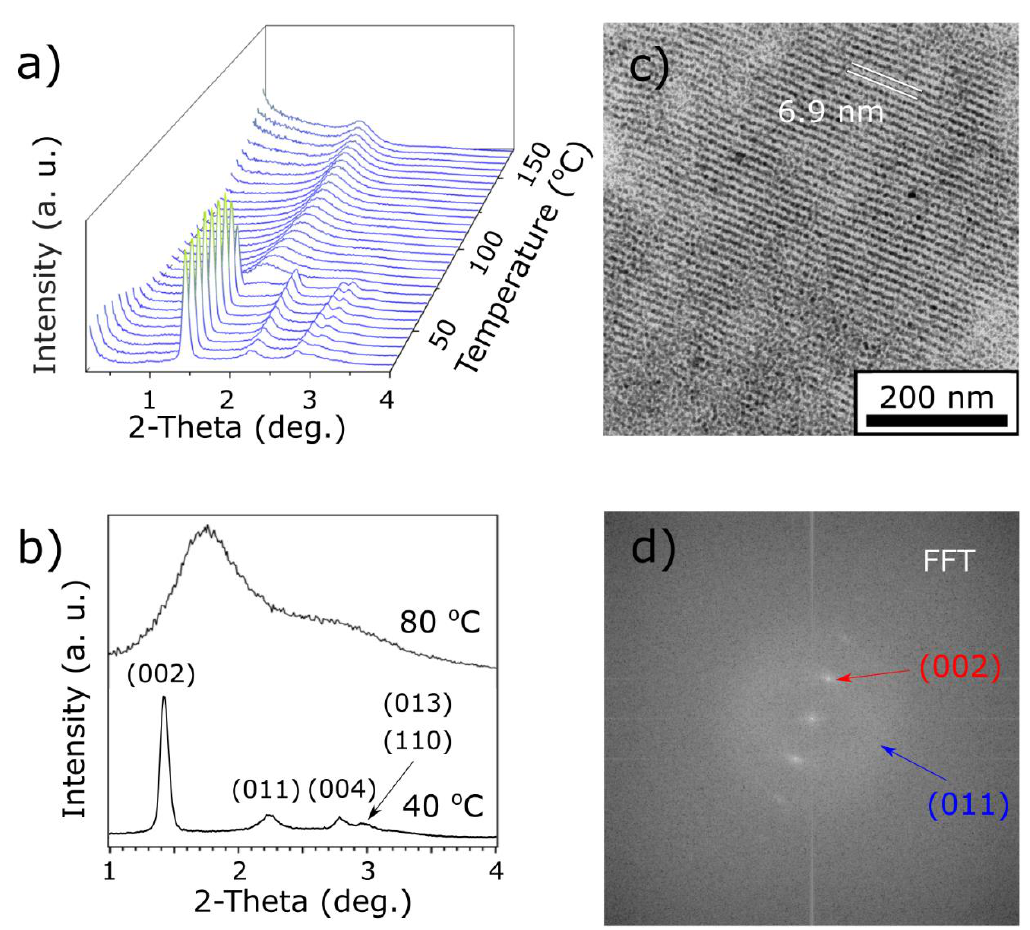
Figure 3. SAXRD and TEM analysis of 3-L M L A material. ( a ) Temperature evolution of the 1D SAXRD profile during heating. ( b ) Comparison of 1D XRD diffractograms collected at 40 and 80 °C. ( c ) TEM image of the heat annealed material. ( d ) 2D Fast Fourier Transformation of the image shown in (c) with maxima assigned to (002) (red arrow) and (011) (blue arrow) lattice planes.